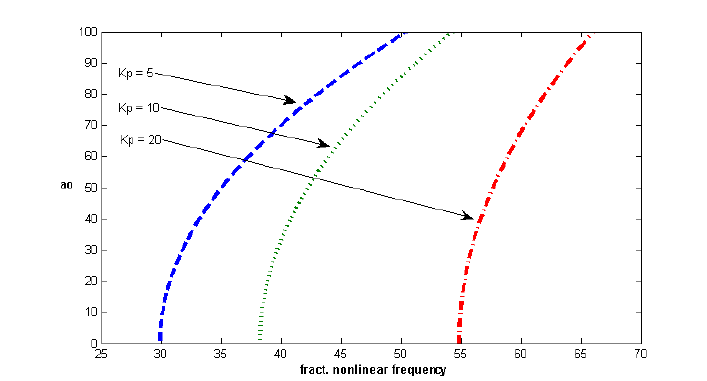
Figure 6. Fractional nonlinear frequency versus amplitude for different values of Kp ( α = 0.5, K = 100, Cp = 0.001, η = 0.5).